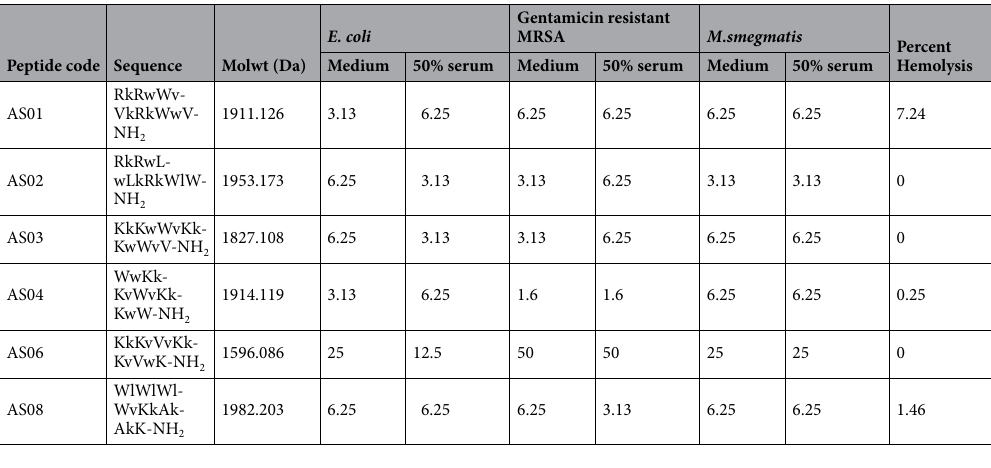
Table 1. Peptide code, sequence, molecular weight and their respective MIC values against Escherichia coli , Gentamicin resistant MRSA and Mycobacterium smegmatis in the presence and absence of serum. The MIC values are expressed in micro-molar (µM) units. The mammalian cytotoxicity potential of the peptides is shown as percent hemolysis. Small letters denote D amino acids within the peptide